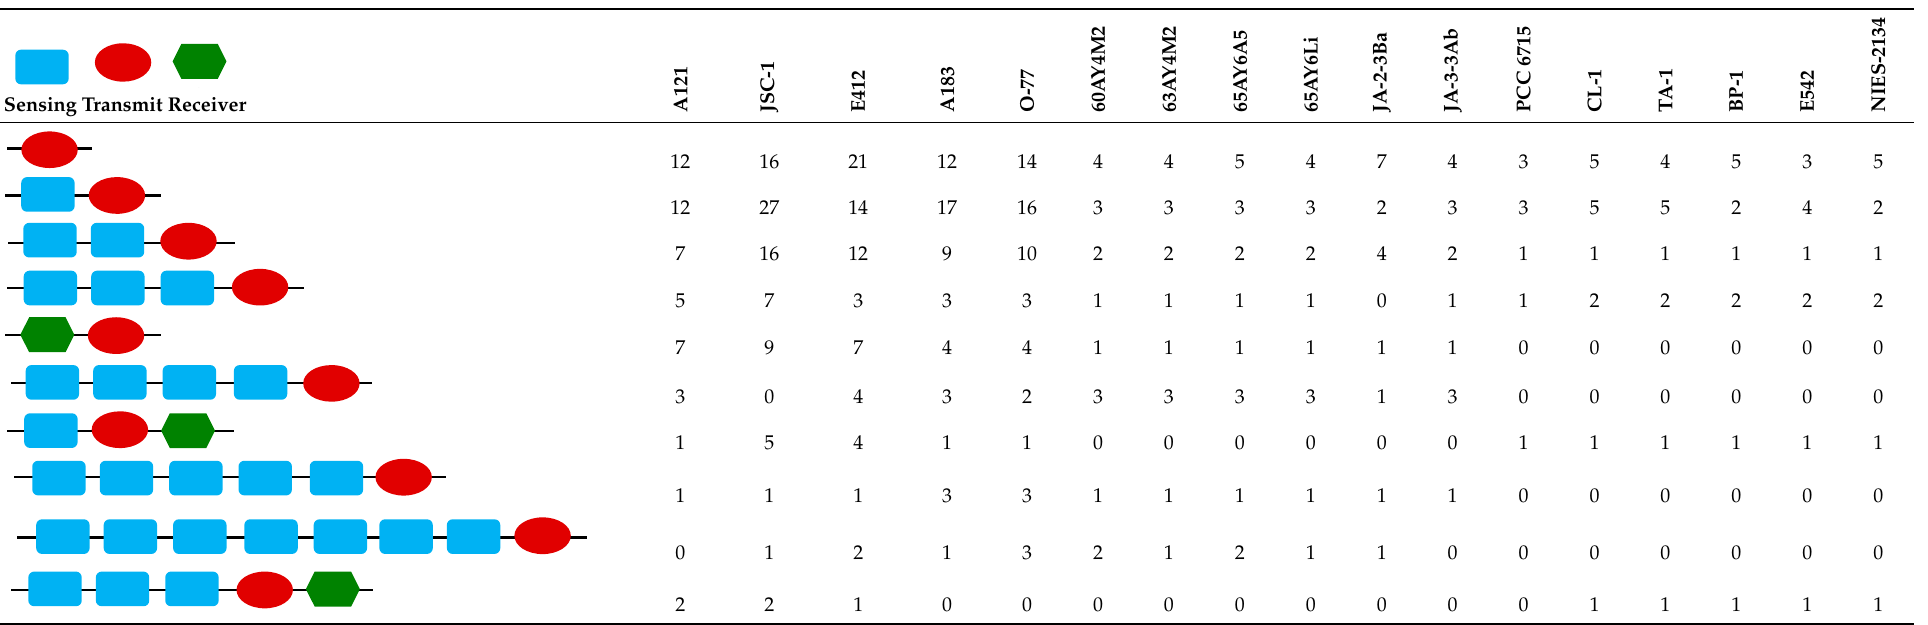
Table 4. Domain architecture of HKs in thermophilic cyanobacteria studied. Only the top 10 abundant domain architectures of HKs were shown. The full version was summarized in Table S4.